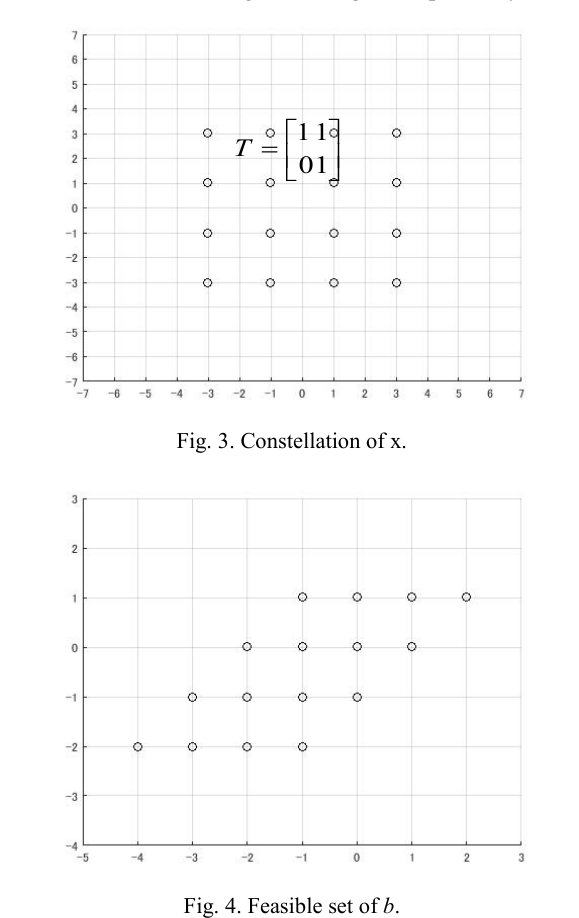
Fig. 4. Feasible set of b